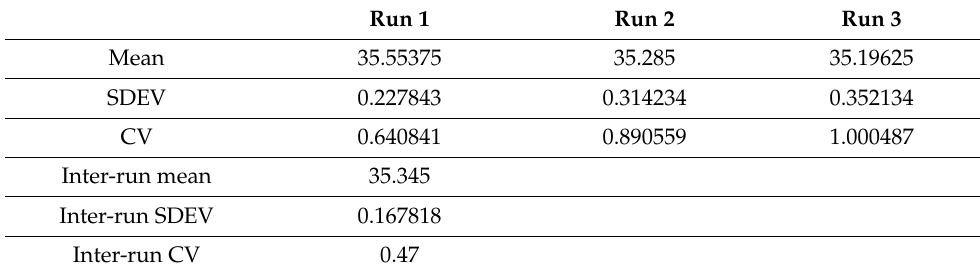
Table 5. Repeatability of the KV-VAC